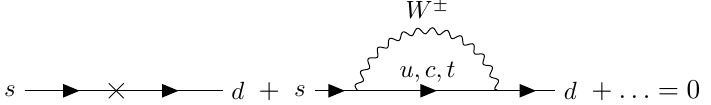
Figure 6 . Relevant diagrams for determining the renormalization constants contributing to s → d . The cross marks the insertion of a counterterm. The dots stand for higher order diagrams in our UV model, such as Z boson-induced flavour changes or diagrams with heavy F